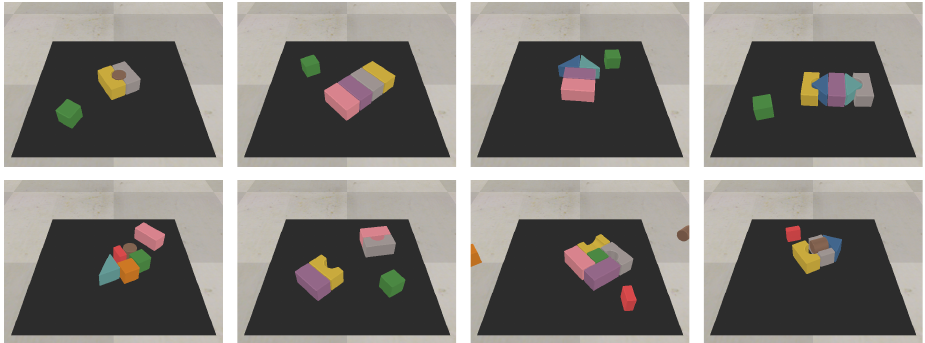
Figure 4. Examples of test scenarios for the simulated environment. Objects are tightly packed forcing the need for synergy between push-and-grasp